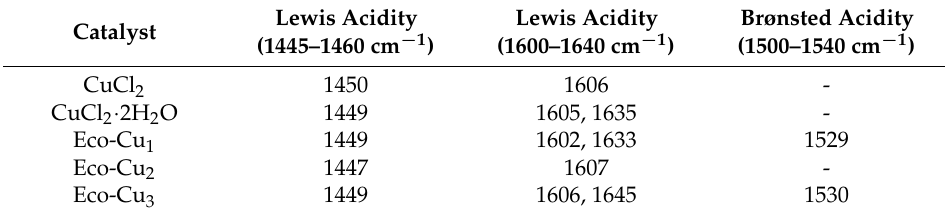
Table 4. The IR spectra of adsorbed pyridine on commercial anhydrous CuCl 2 , on CuCl 2 ·2H 2 O, and on Eco-Cu 1–3 .